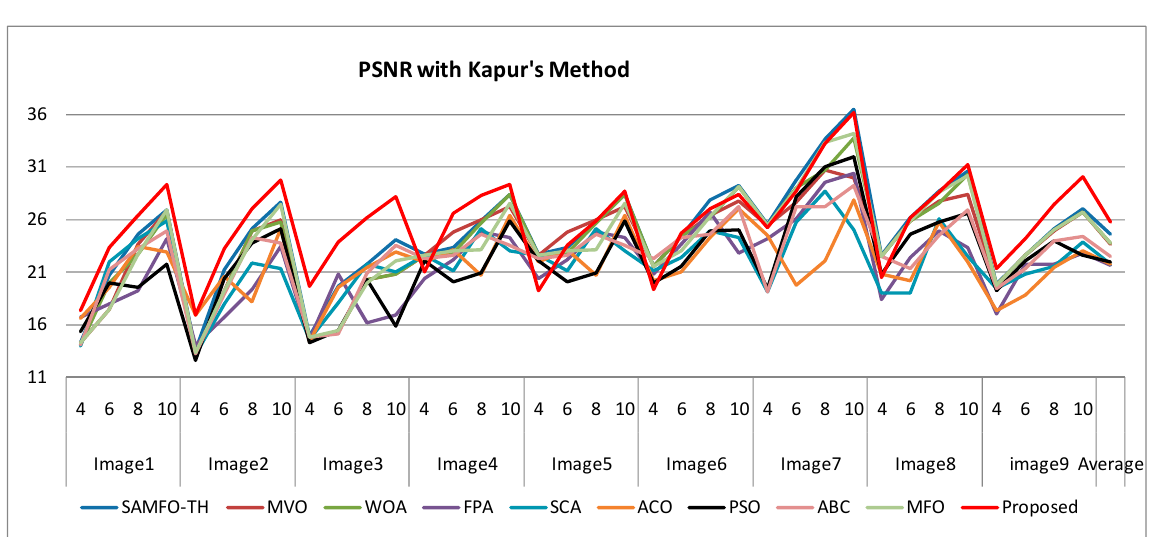
Figure 10. Comparison of PSNR based on Kapur’s method.